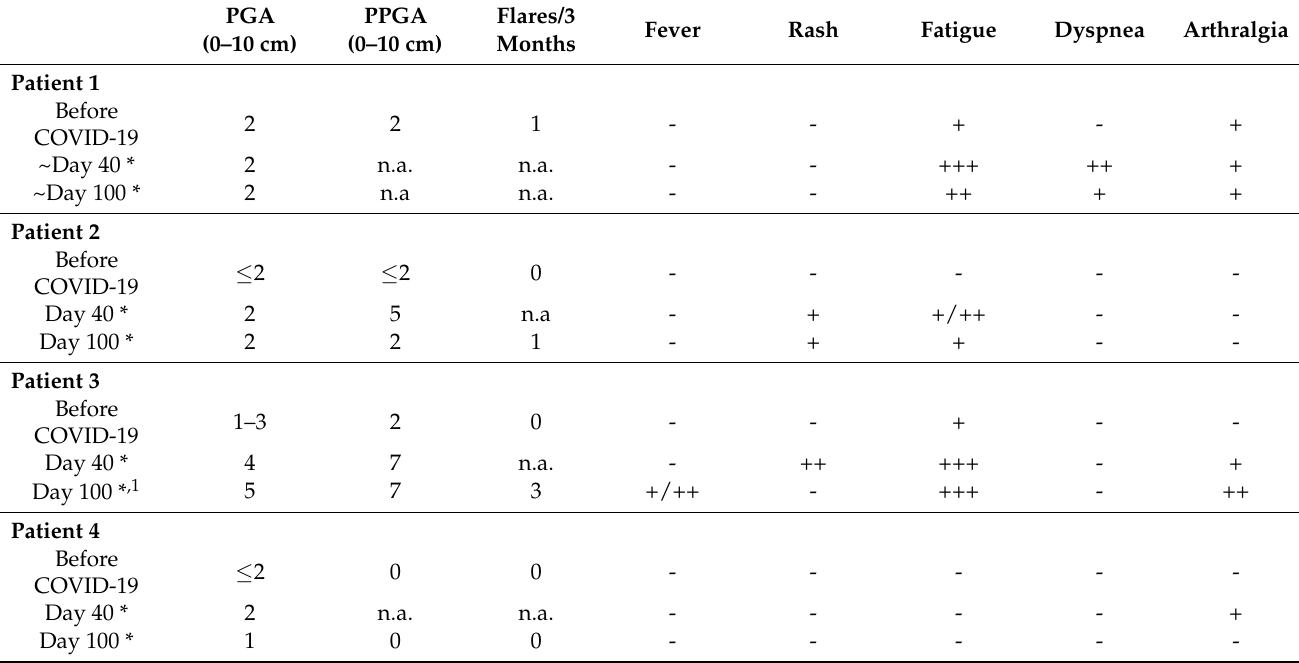
Table 1. Clinical symptoms before and after COVID-19 symptom onset.